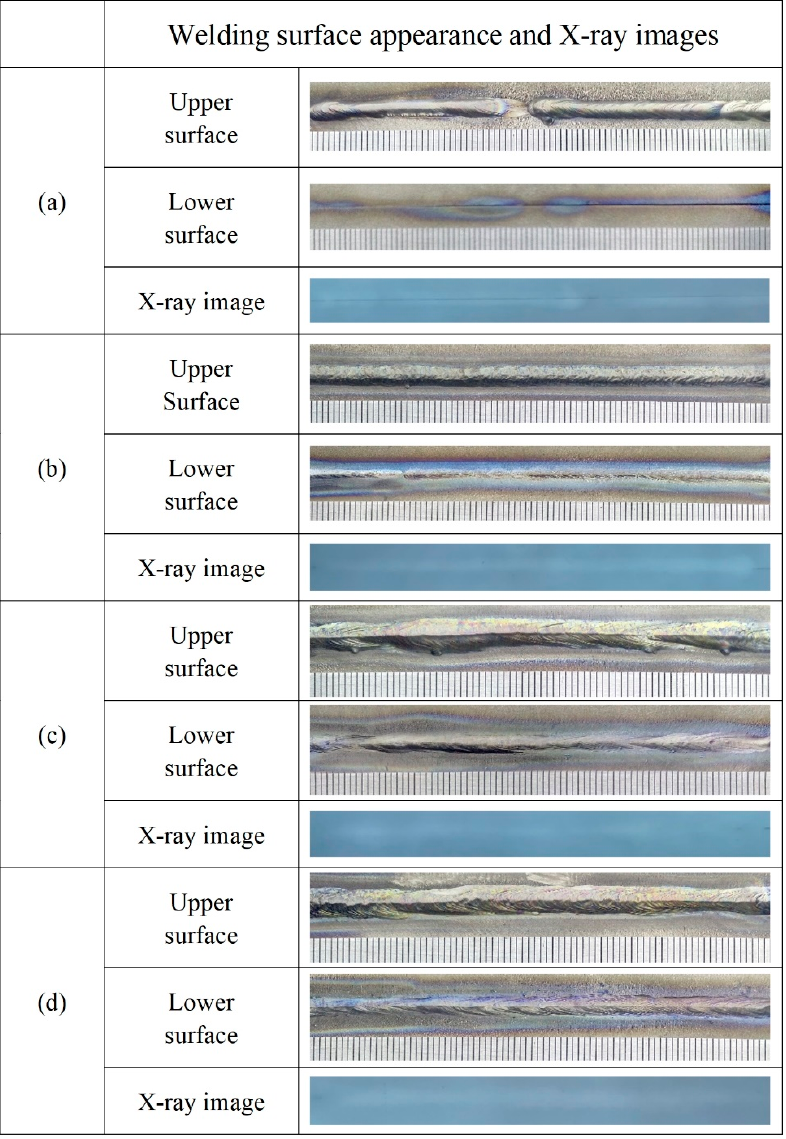
Figure 11. The welding surface appearance and X-ray images at different laser powers; ( a ) 2.5 kW; ( b ) 3 kW; ( c ) 3.5 kW; ( d ) 4 kW.